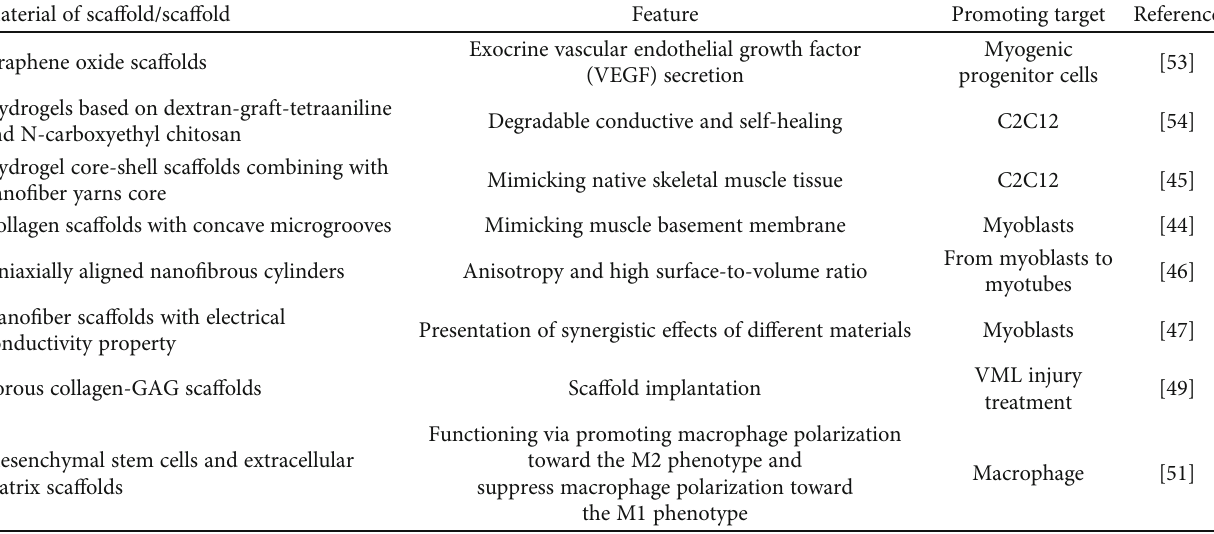
Table 1: Classi fi cation of di ff erent sca ff